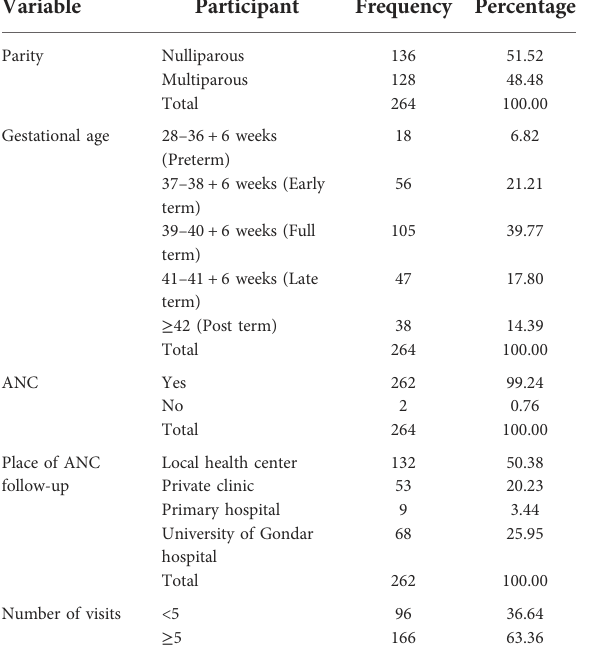
TABLE 2 Obstetric characteristics of study participants, 2021 [ N =264].